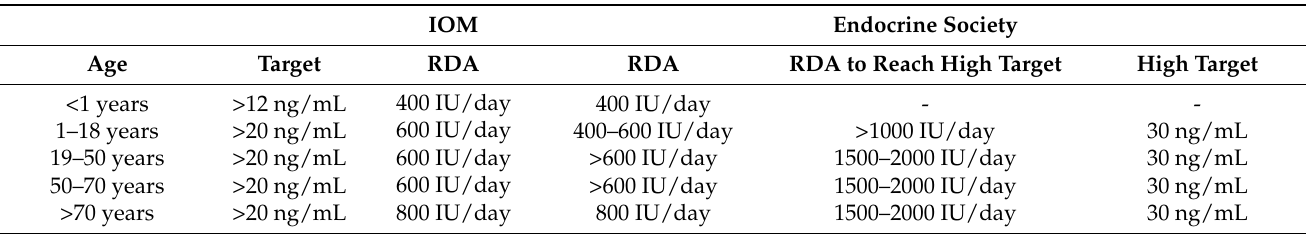
Table 1. RDA needed to reach vitamin D target levels in different age considering IOM and Endocrine Society Clinical Practice guidelines [16,18].